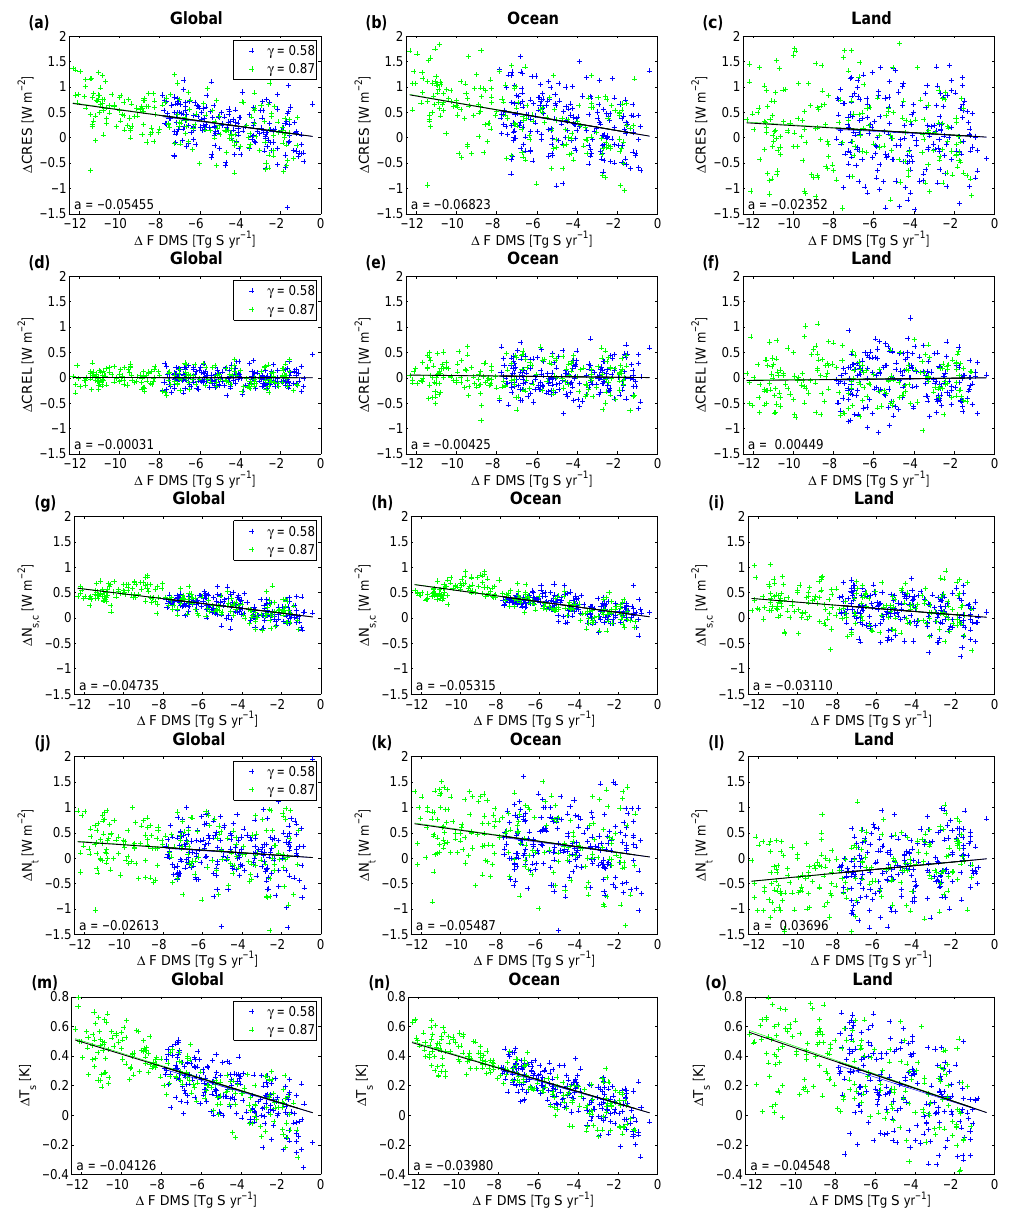
Figure 7. Scatter plots of anomalies of sea–air DMS fluxes ( (cid:49)F DMS , TgSyr − 1 ) versus anomalies of (a) – (c) shortwave cloud radiative effect ( (cid:49) CRE s , Wm − 2 ), (d) – (f) longwave cloud radiative effect ( (cid:49) CRE l , Wm − 2 ), (g) – (i) clear-sky net shortwave radiative flux at the top of model ( (cid:49)N s , c , Wm − 2 ), (j) – (l) total radiative flux at the top of model ( (cid:49)N t , Wm − 2 ), and (m) – (o) near-surface temperature ( (cid:49)T s , K) for the experiments SMED (blue) and SHIGH (green) relative to experiment BASE. The first column of plots displays global annual averages for each year in 2006 to 2200, while for the second and third column the annual mean values were calculated for ocean and land grid points, respectively. A linear fit to the data of each experiment (solid blue and green lines) as well as a linear fit to all data (solid black line) is shown in each panel. Note that in most cases the fit to individual experiments is indistinguishable from the fit to all data points and is hidden behind the black solid lines. The slope of the fit to all data is given in the lower left corner of each panel.